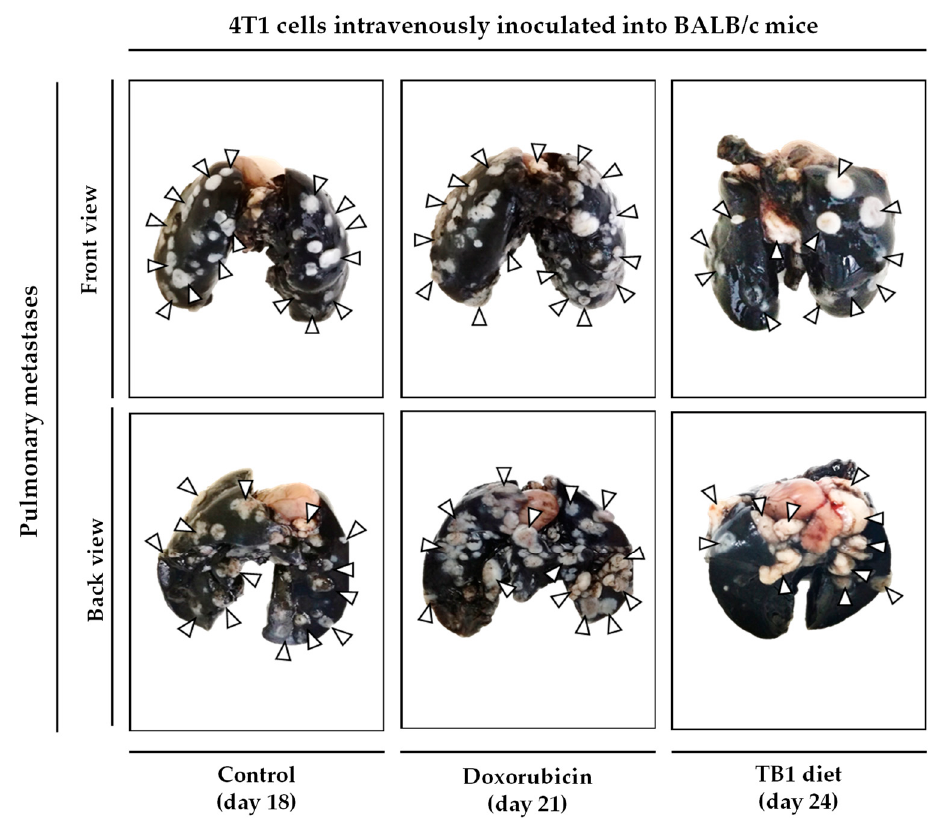
Figure 4. Lung photographs at the time of sacrifice of representative mice with TNBC. In this model, 100,000 4T1 murine breast cancer cells are inoculated in the tail vein of immunocompetent BALB/c mice. After 8 days, mice were treated with doxorubicin (0.5 mg/kg/day, every week for a total of 4 doses), with diet TB1 (normal diet was replaced by TB1 for 28 days) or untreated (control, normal diet). Mice were euthanized by cervical dislocation when signs of disease progression were apparent. After sacrifice, lungs were excised and stained with India ink (tumors show a white appearance and normal lung parenchyma appears black; some photographs show the unstained heart). Mice were sacrificed at different time points, when symptoms of advanced disease were patent. The day of sacrifice is shown in brackets.